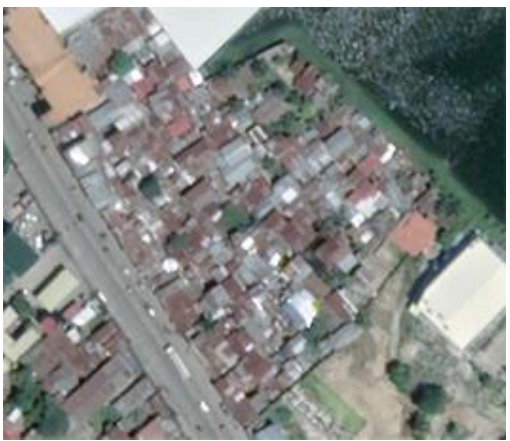
Figure 9: Tamiya, Barangay Basak, Lapu-lapu City